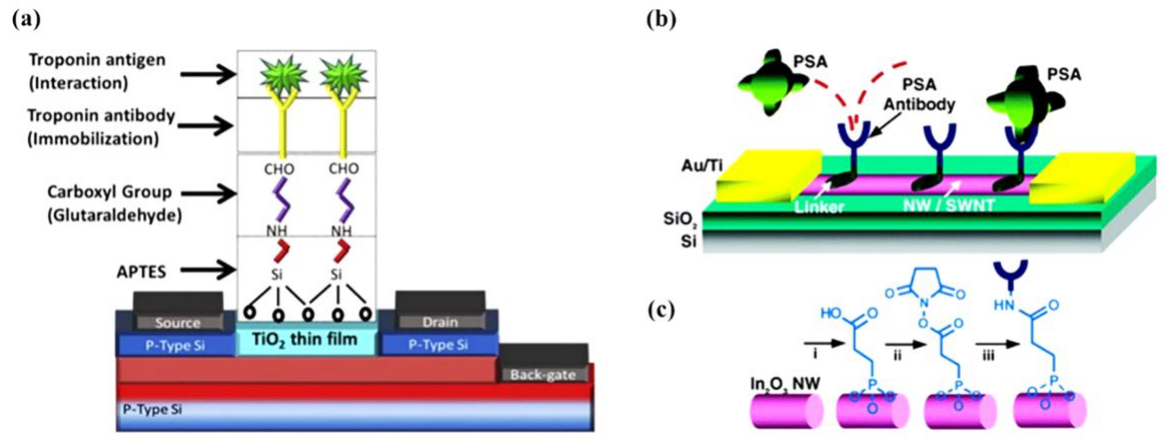
Figure 6. ( a ) A TiO2 thin film-based biosensor’s surface functionalization process involves silanization with APTES, reaction with bifunctional linker (glutaraldehyde), and covalent antibody conjugation. Reprinted from Ref. [144] with permission from Elsevier. Copyright © 2017, Elsevier BV All rights reserved. ( b ) Schematic diagram of FET-based In 2 O 3 NW biosensors for the prostate-specific antigen (PSA). Monoclonal antibodies (Abs) are anchored to the surface of the NWs and serve as specific recognition groups for PSA. ( c ) Reaction sequence for the functionalization of In 2 O 3 NW: i, 3-phosphonopropionic acid deposition; ii, DCC and N-hydroxysuccinimide activation; iii, PSA-Abs incubation. Reprinted from Ref. [142] with permission from ACS. Copyright © 2005, American